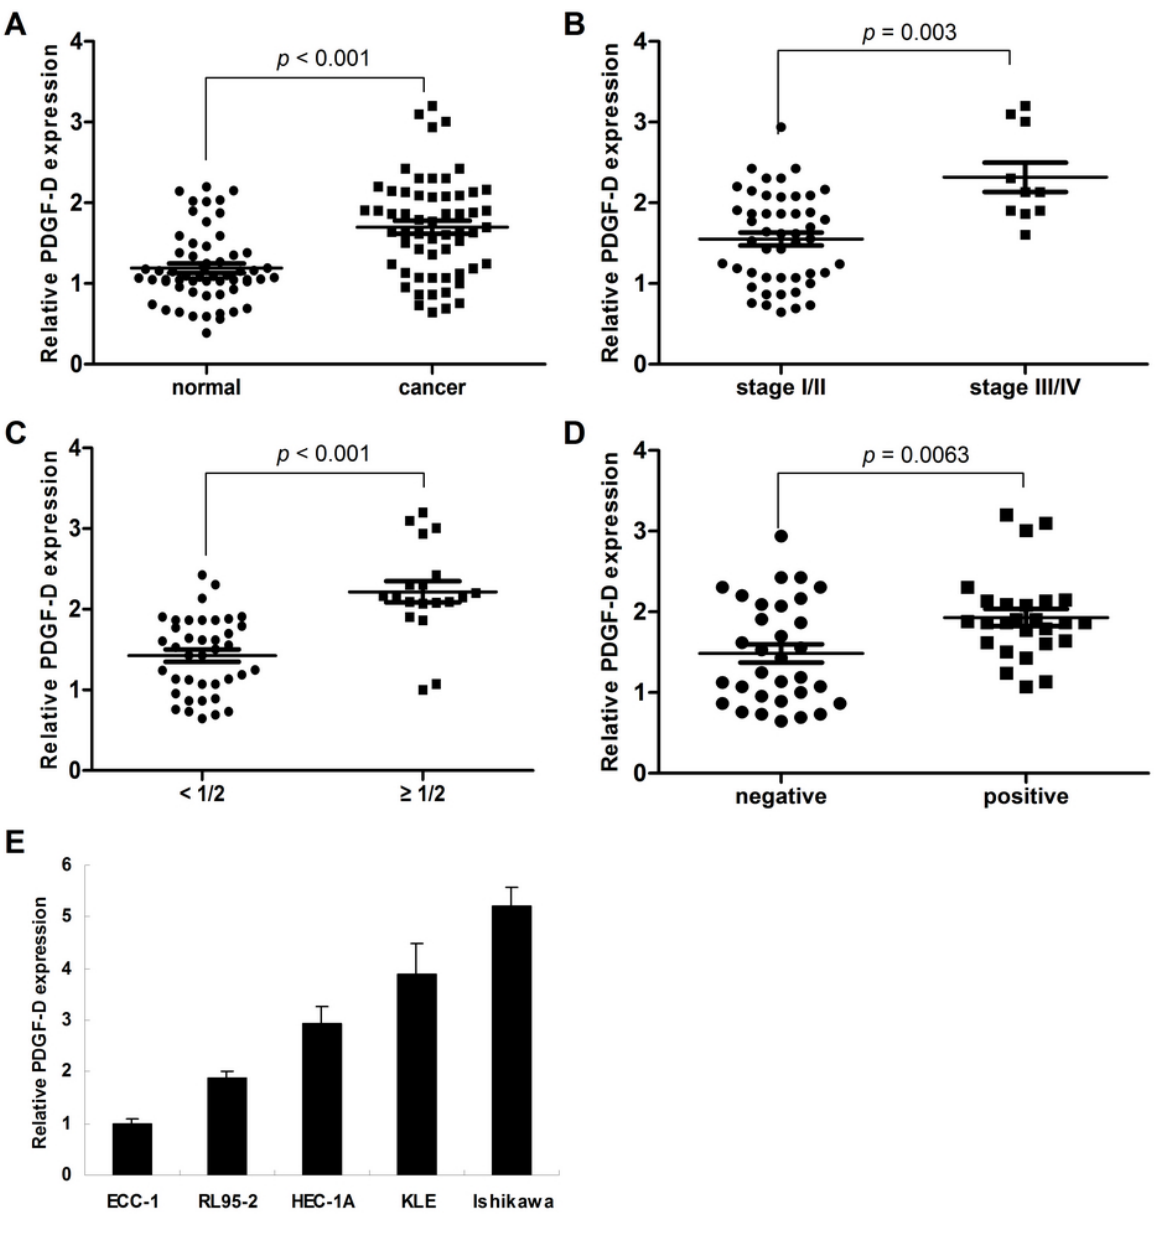
Figure 2. The relationship between PDGF-D over-expression and clinico-pathology characteristics. ( A ) The protein of PDGF-D was notably higher in endometrial cancer than those in the normal tissues ( p < 0.001); ( B ) PDGF-D over-expression was associated with late stage (stage III/IV, p = 0.003); ( C ) PDGF-D over-expression was associated with deep myometrial invasion ( p < 0.001); ( D ) PDGF-D over-expression was associated with lympha vascular space invasion ( p = 0.006); ( E ) Among the five endometrial cancer cell lines, ECC-1 has the lowest and Ishikawa has the highest mRNA expression of